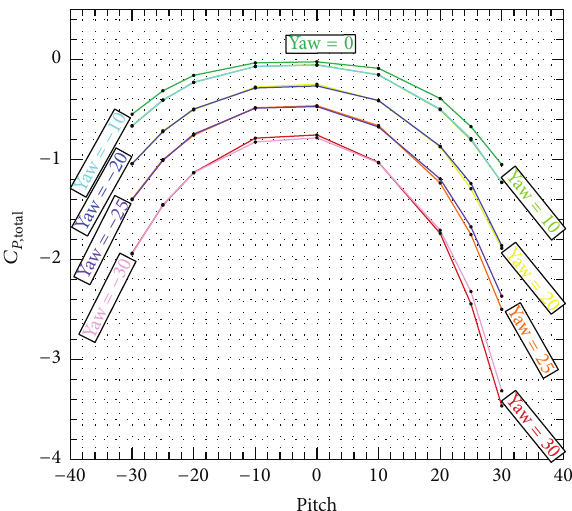
Figure 9: Pitch and coefficient of total pressure with lines of constant yaw, 81 (9 × 9) points.